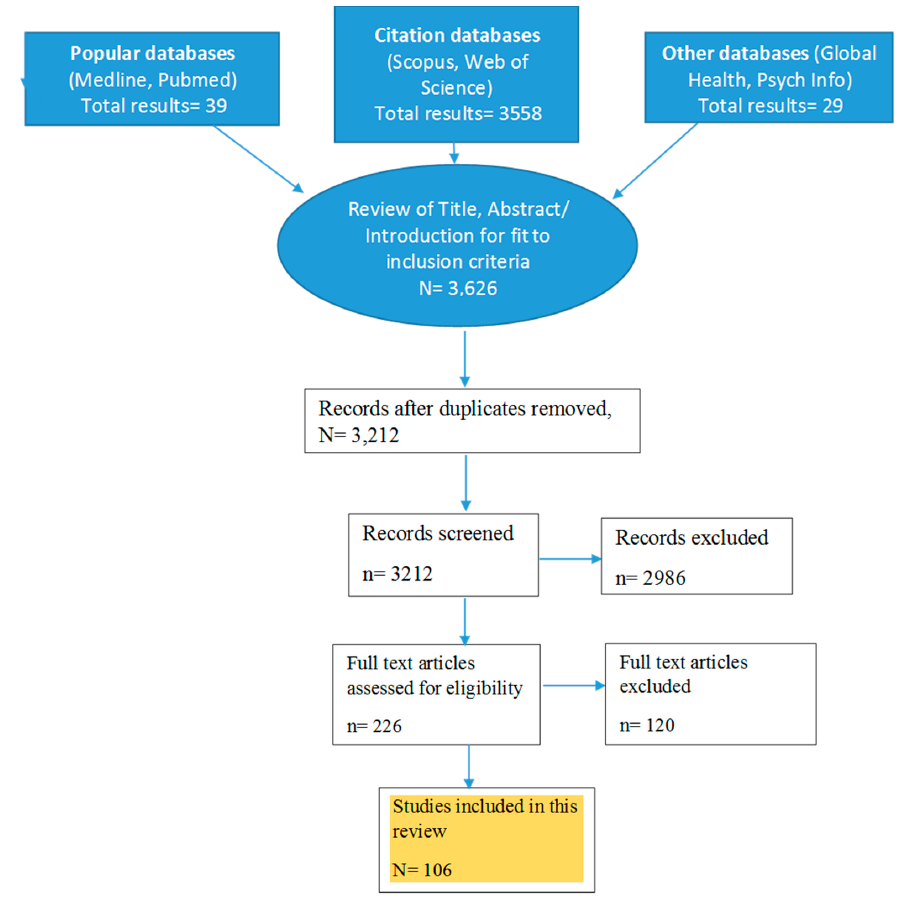
Figure 1. Flow chart of literature search.